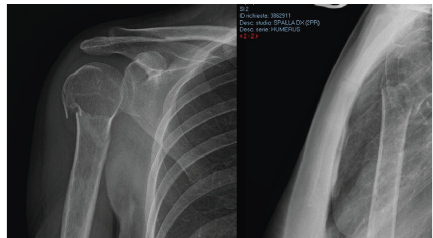
Figure 1: A standard anterior-posterior and axillary X-ray view of a PHF.